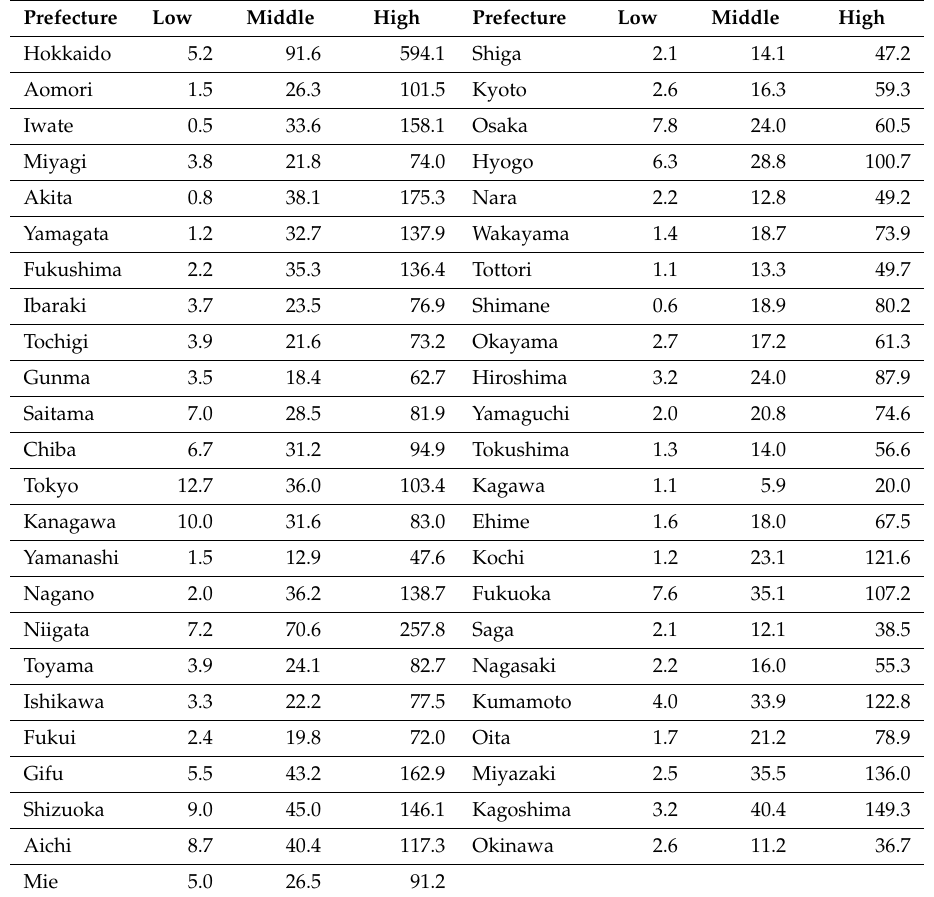
Table A2. Minimum, median, and maximum values of plastic emissions by prefecture (Unit: t /